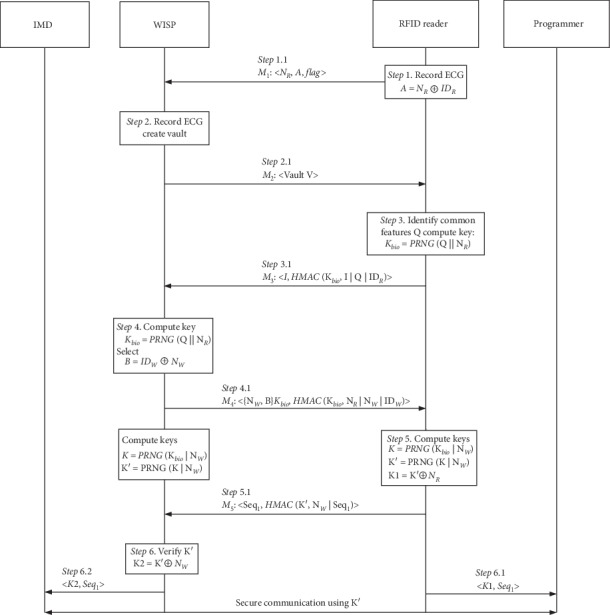
The proposed mutual authentication protocol in the emergency mode (protocol 3).